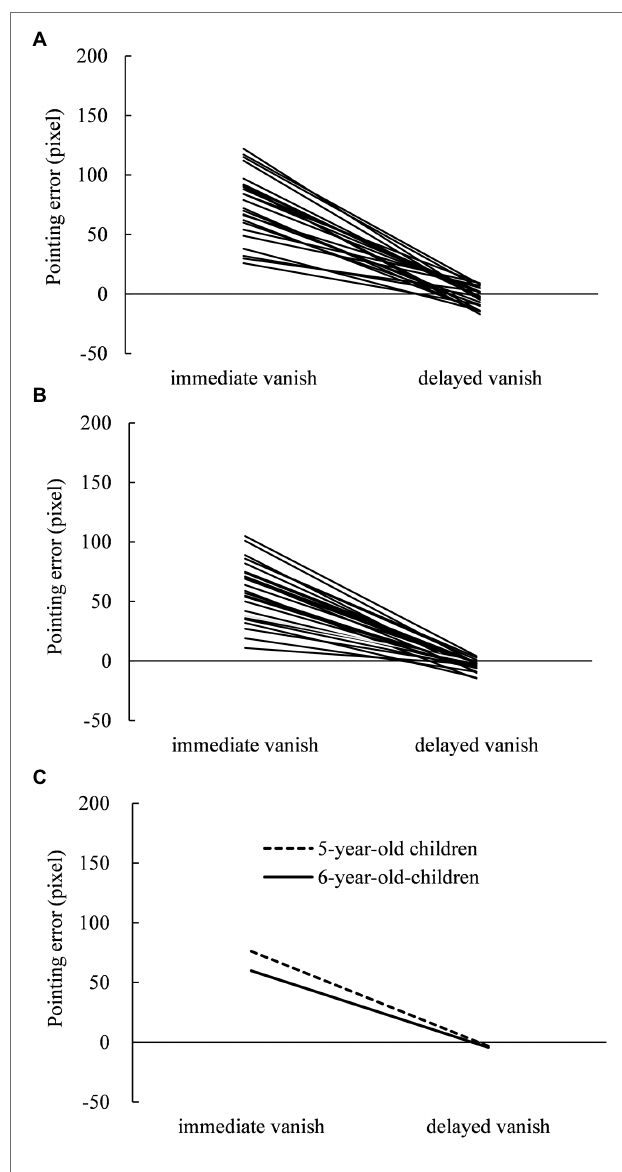
FIGURE 1 | Individual pointing errors (displacement between the pointed position and actual vanishing point) in the pointing task under the immediate- and delayed-vanishing conditions in (A) 5-year-old children and (B) 6-year-old children with (C) mean pointing errors for